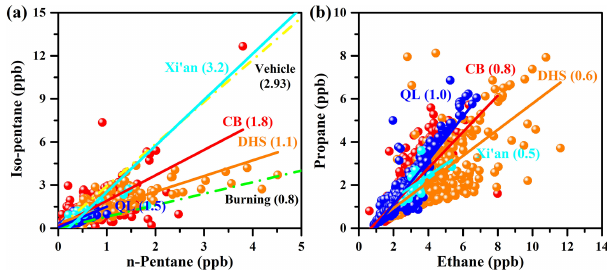
Figure 7. Linear correlations ( R 2 ) between (a) iso-pentane and n - pentane and (b) propane and ethane at the CB (red), DHS (orange), QL (blue), and gridded sampling sites (light